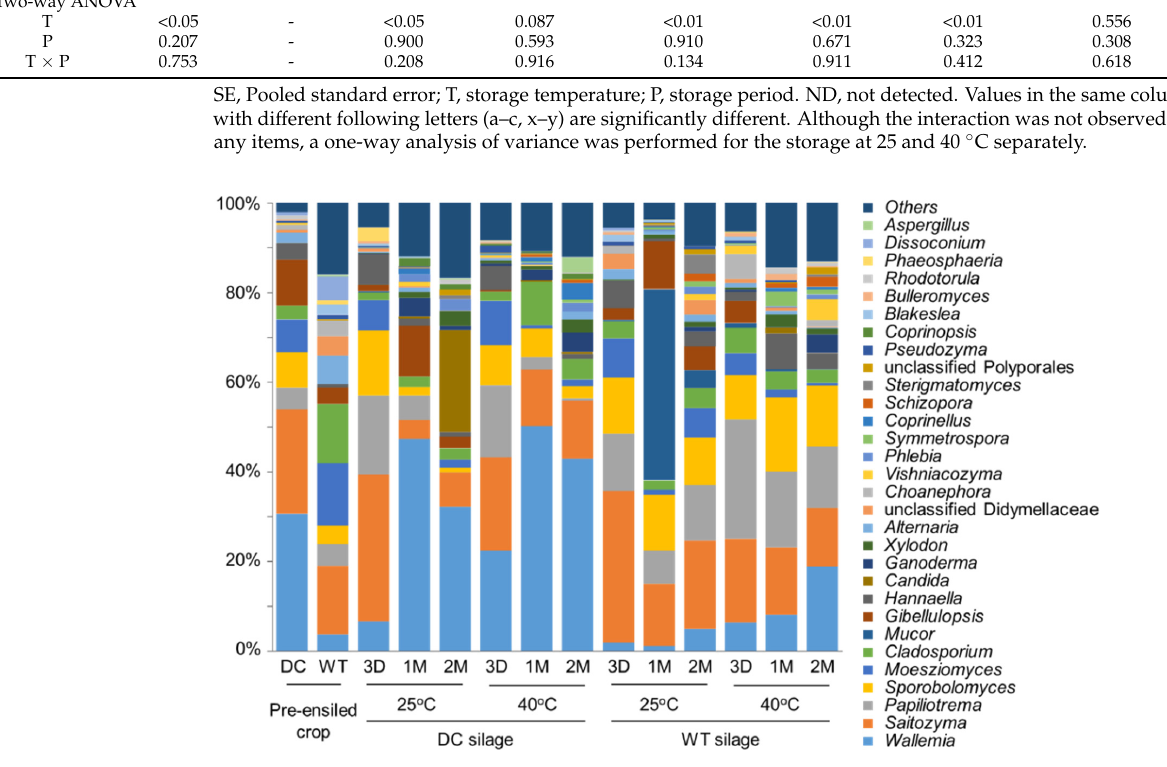
Figure 3. Relative abundances of the 30 major genera (>1% in abundance) of the fungal microbiota of pre-ensiled crops and silages prepared from direct-cut and wilted guinea grass. DC and WT indicate direct-cut and wilted crops and silages. 3D, 1M, and 2M indicate storage for 3 days, 1 month, and 2 months at 25 and 40 °C, respectively. Table 6. Relative abundances (%) of the eight most abundant fungal genera in wilted guinea grass silage stored at 25 and 40 °C for 3 days, 1 month, and 2 months.